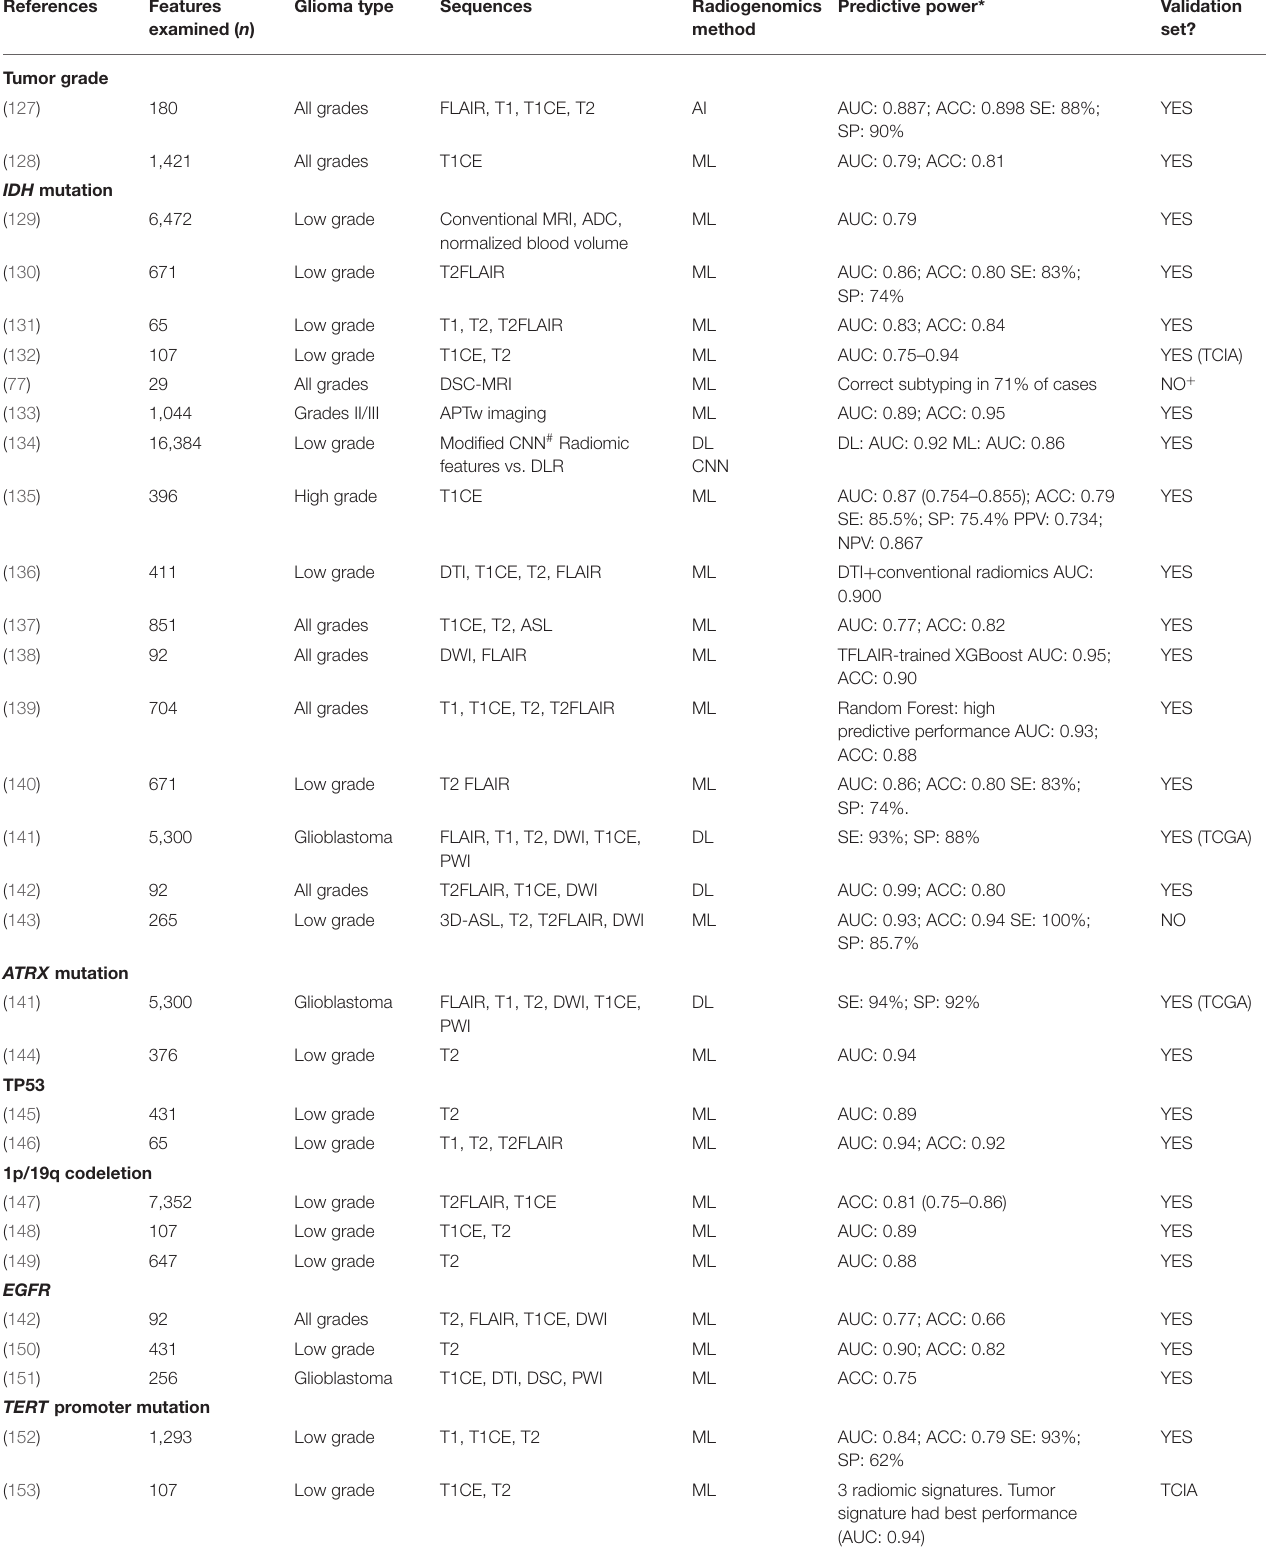
TABLE 4 | Tumor grade and molecular alterations identified by imaging with conventional radiology and